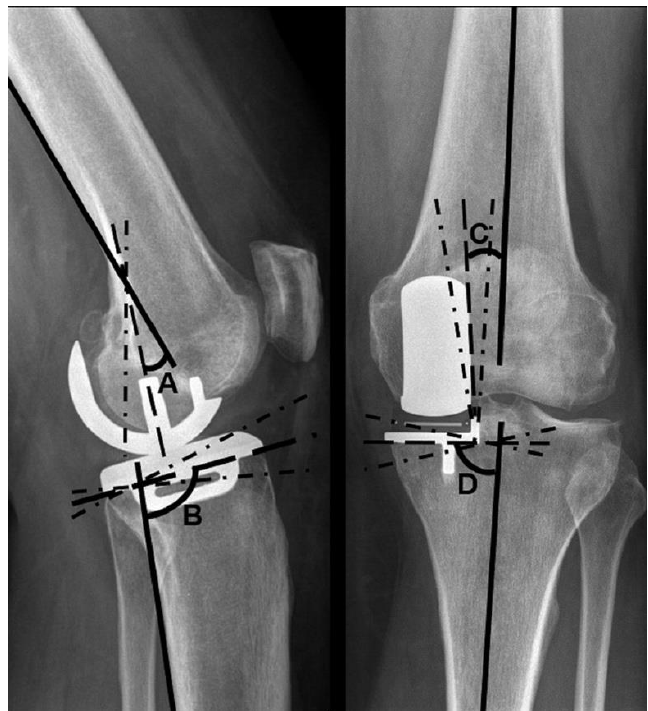
Figure 1. Zones of radiolucent lines ( A )—femoral, ( B )—tibial.